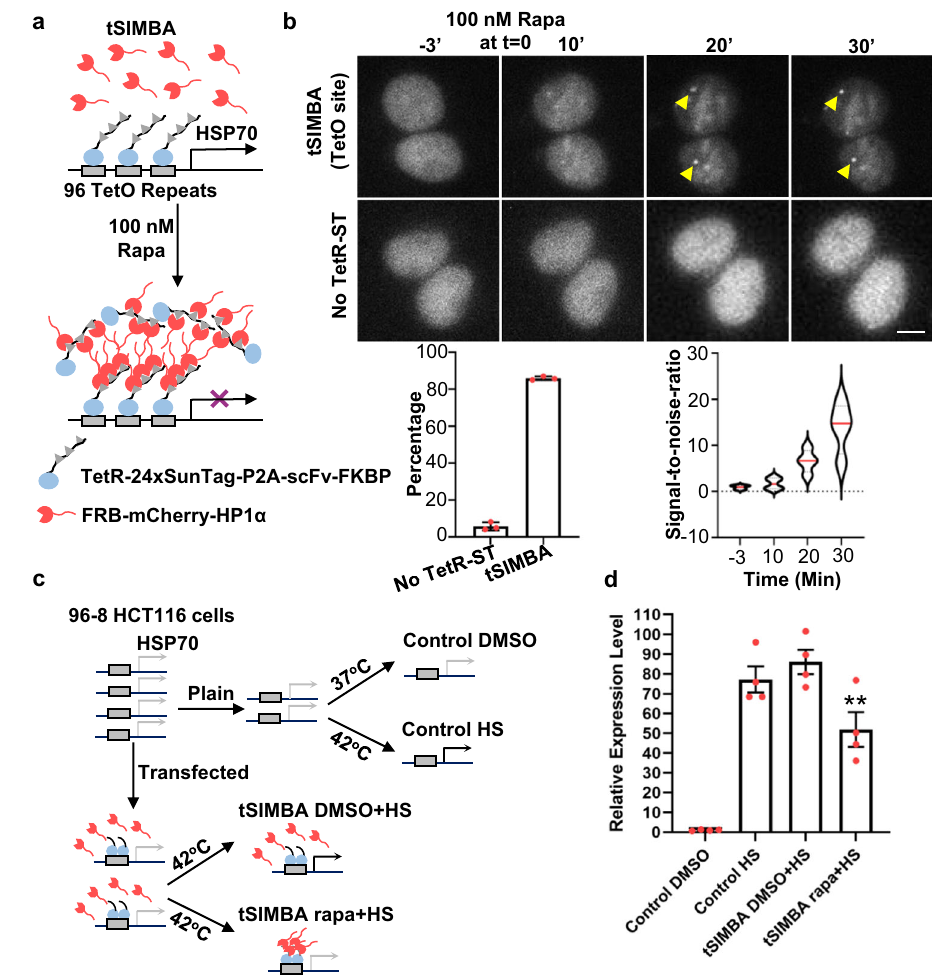
Fig. 3 | SIMBA enables puncta formation at a synthetic site inserted in the genometosuppresslocalgeneexpression.a SchematicdiagramoftSIMBA,with itscomponentsincludingTetR-24xSunTag-P2A-scFv-FKBPandFRB-mCherry-HP1 α . Upon rapamycin addition, HP1 α is recruited to the 96xTetO site in engineered HCT116 cells to regulate heat shock (HS)-induced gene expression. b Top panel: Time-lapse images showing puncta formation at the single engineered TetO site (Yellow arrow) in the genome of a HCT116 cell following 100nM rapamycin treat- ment. In contrast, no TetO labeling can be observed in the negative control group withoutTetR-24xSunTag-P2A-scFv-FKBP.Bottompanel:thepercentageofthecells with puncta and SNR from top panel were quanti fi ed. SNR number was listed in SupplementaryData1. n =3biologicallyindependentexperimentsforbothgroups.